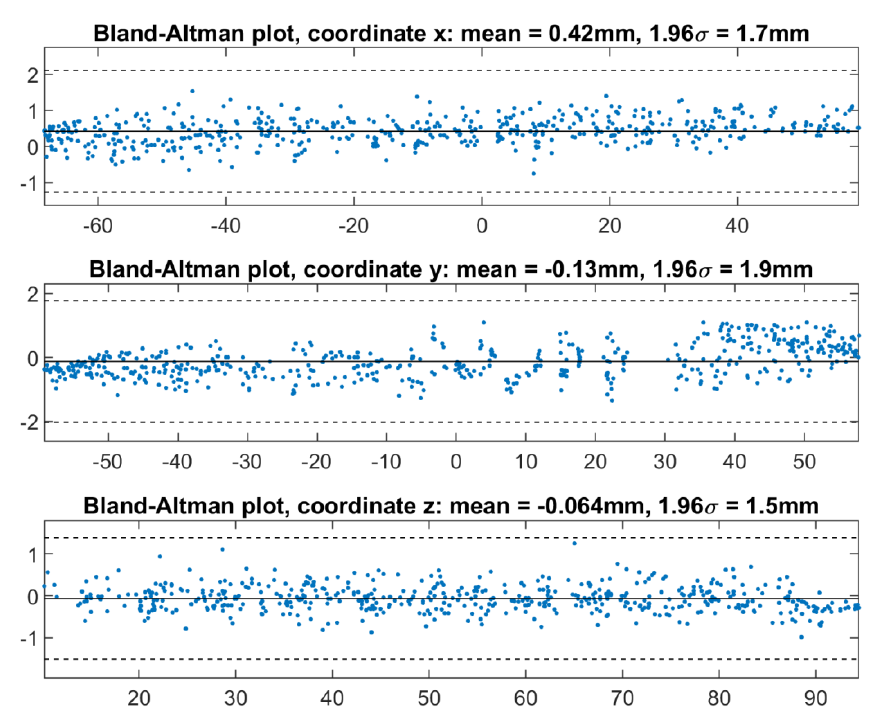
Figure 8. Bland – Altman plots of the coordinate differences between PhotoMeDAS (scale factor 0.99) and CNC CMM (ground truth).